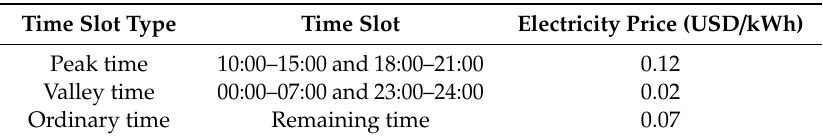
Table 2. Time-of-use tariff mechanism for external networks.